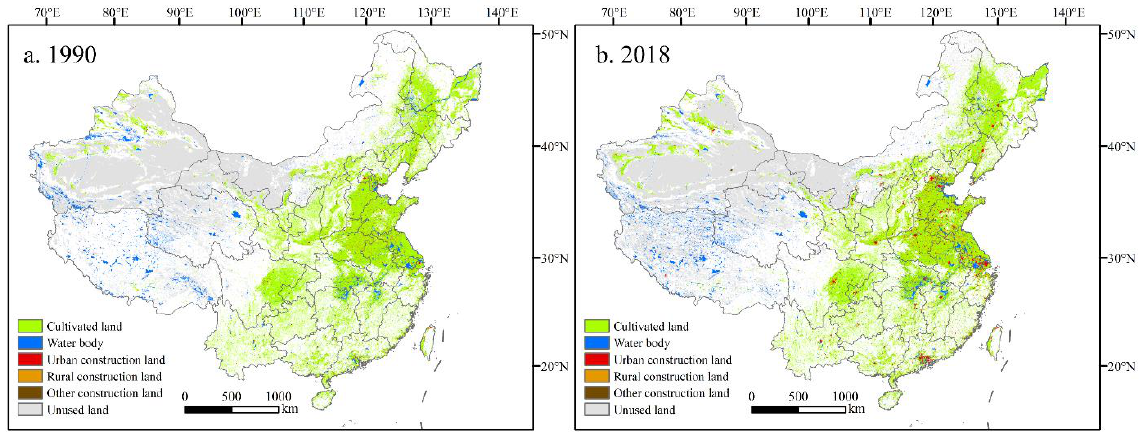
Figure 1. Land use data of China in 1990 and 2018.